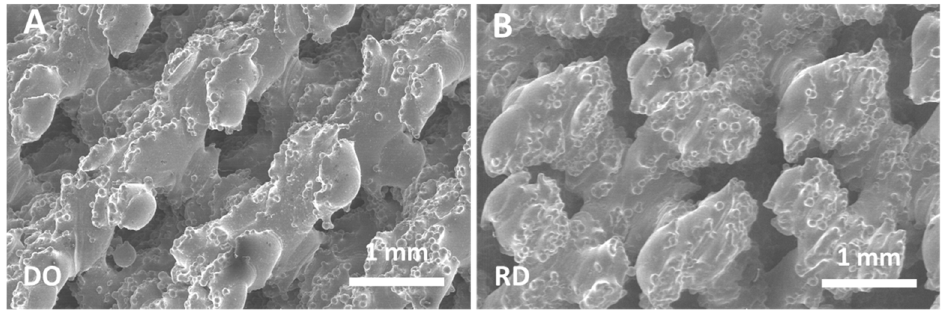
Figure 4. FESEM images of the scaffold’s top surface: ( A ) DO geometry, ( B ) RD geometry. The scaffold’s inner structure showed pores partially filled with unmelted and neck connected powder particles (Figure 5A,B).